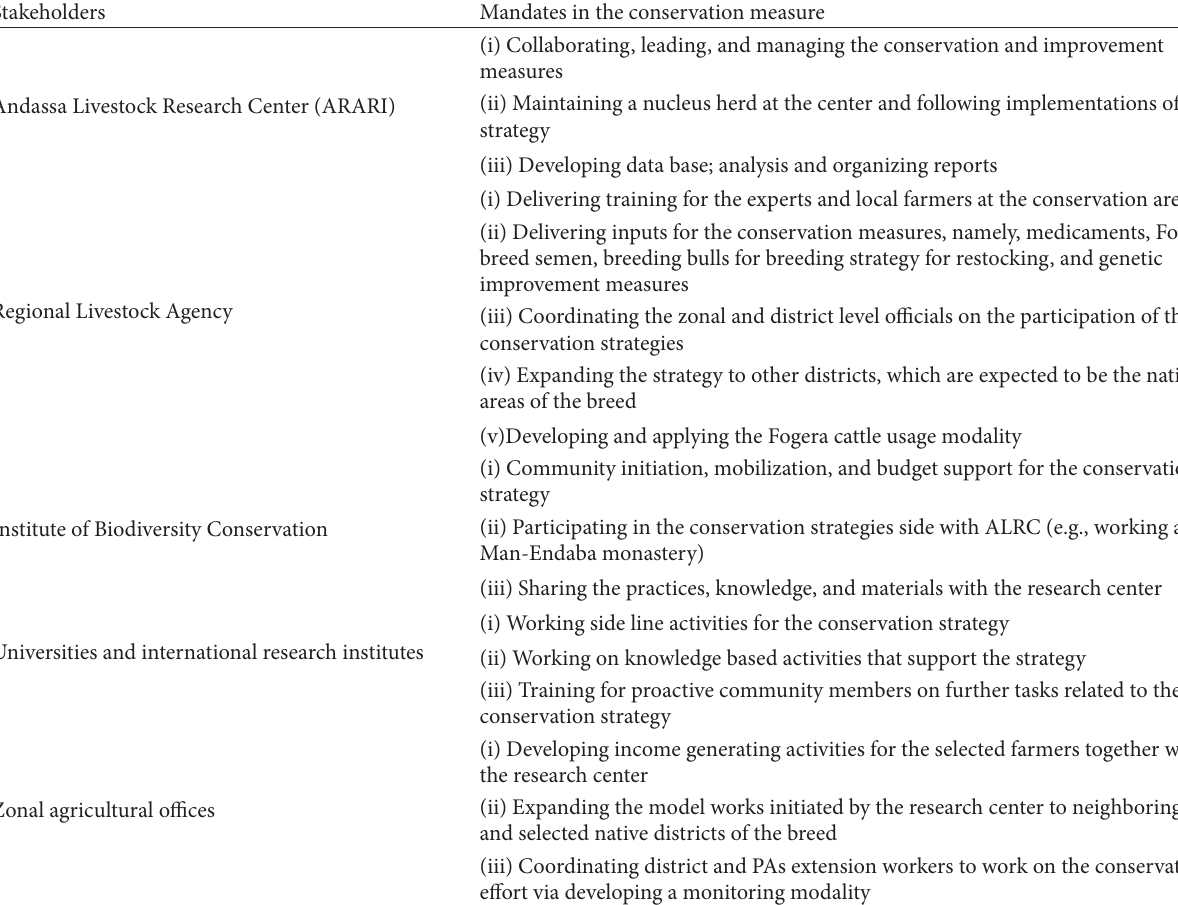
Table 6: Major stakeholders and their role in the conservation strategy of Fogera